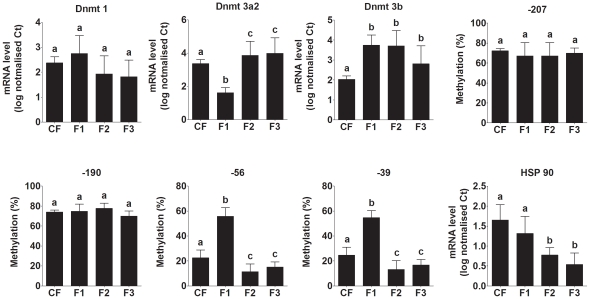
Hepatic DNA methyltransferase expression and Dnmt3a2 promoter methylation, and embryo heat shock protein 90 expression.Dnmt 1, Dnmt 3a2 and Dnmt3b mRNA expression in the liver of non-pregnant adult offspring on postnatal day 70. Methylation of individual CpGs in the Dnmt 3a2 promoter in adult offspring. HPS 90 mRNA expression in post-conception day 8 gastrulating embryos. Values are mean ± SD, n = 5 to 7 samples per group. Values with different letters are significantly different (P<0.05).